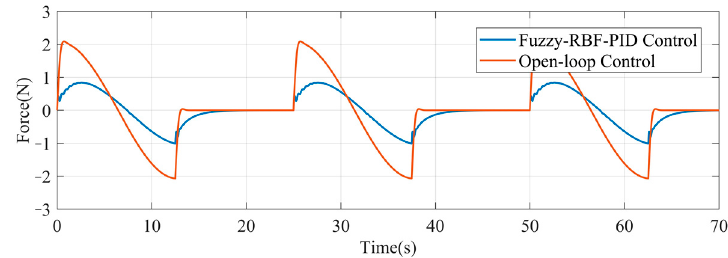
Figure 8. Dynamic tracking error of the output force.